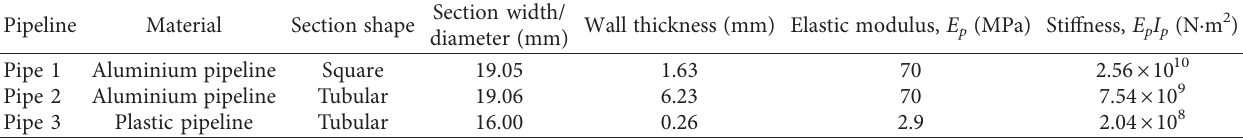
Table 5: Pipeline parameters used in the centrifuge model tests.